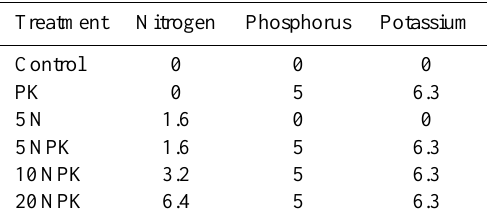
Table 1. Fertilization at Mer Bleue in gm − 2 yr − 1 in triplicate 3m × 3m plots in areas of similar hummock vegetation. 5N corre- sponds to 5 times the ambient summer N deposition.